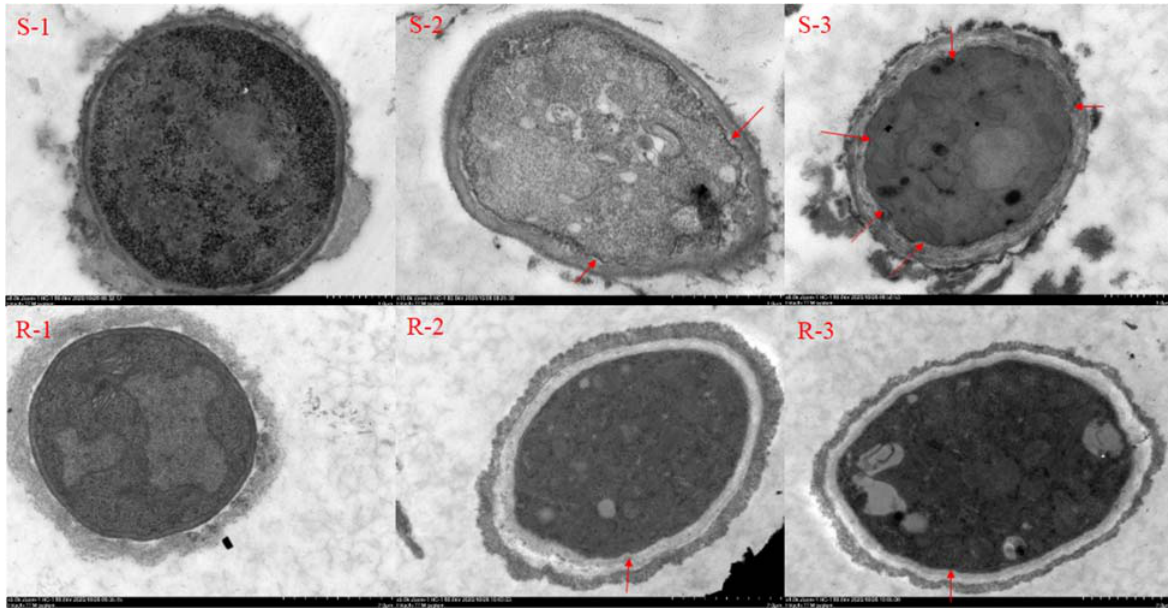
Figure 2. Effect of SYAUP-CN-26 on B. cinerea cell membrane. S—sensitive strain; R—resistant strain; R-1: resistant control; S-1: sensitive control; 2—26.758 µg/mL; 3—79.754 µg/mL, red arrow: cell membrane fold.